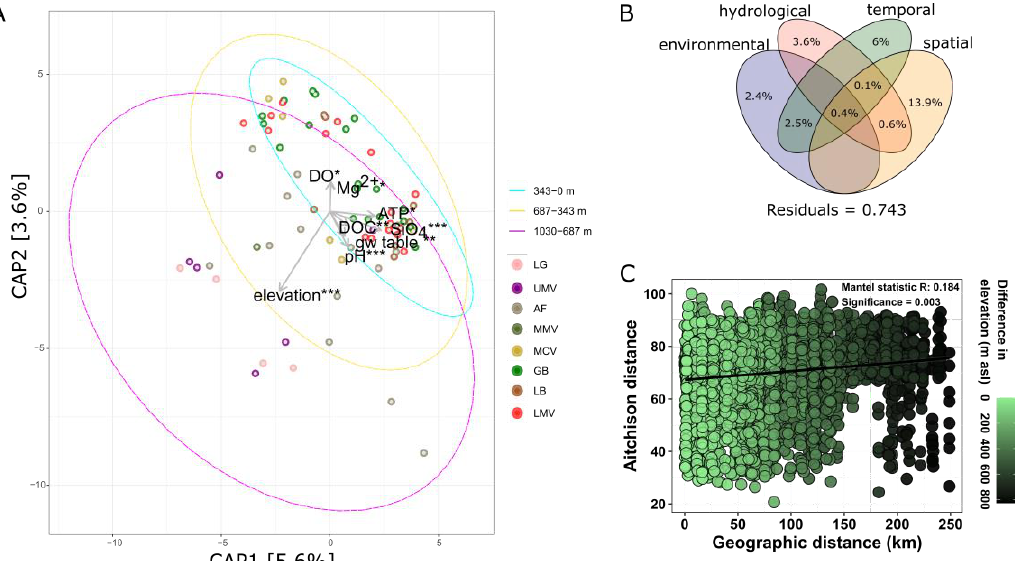
Figure 8. ( A ) Ordination of species turnover with a constrained analysis of principal coordinates (CAP) based on clr-transformed abundances between groundwater wells in association with respec- tive environmental parameters (*** p < 0.001, ** p < 0.01, * p < 0.05). ( B ) Venn diagram showing the proportions of variation explained by four explanatory factors: environmental factors, hydrological factors, temporal, and spatial factors. ( C ) Biplot of the Aitchison distance and geographic distance depicting the distance decay relationship with circles colored according to the difference in eleva- tion between sample pairs, showing Spearman correlation coefficient (R) as well as p value.